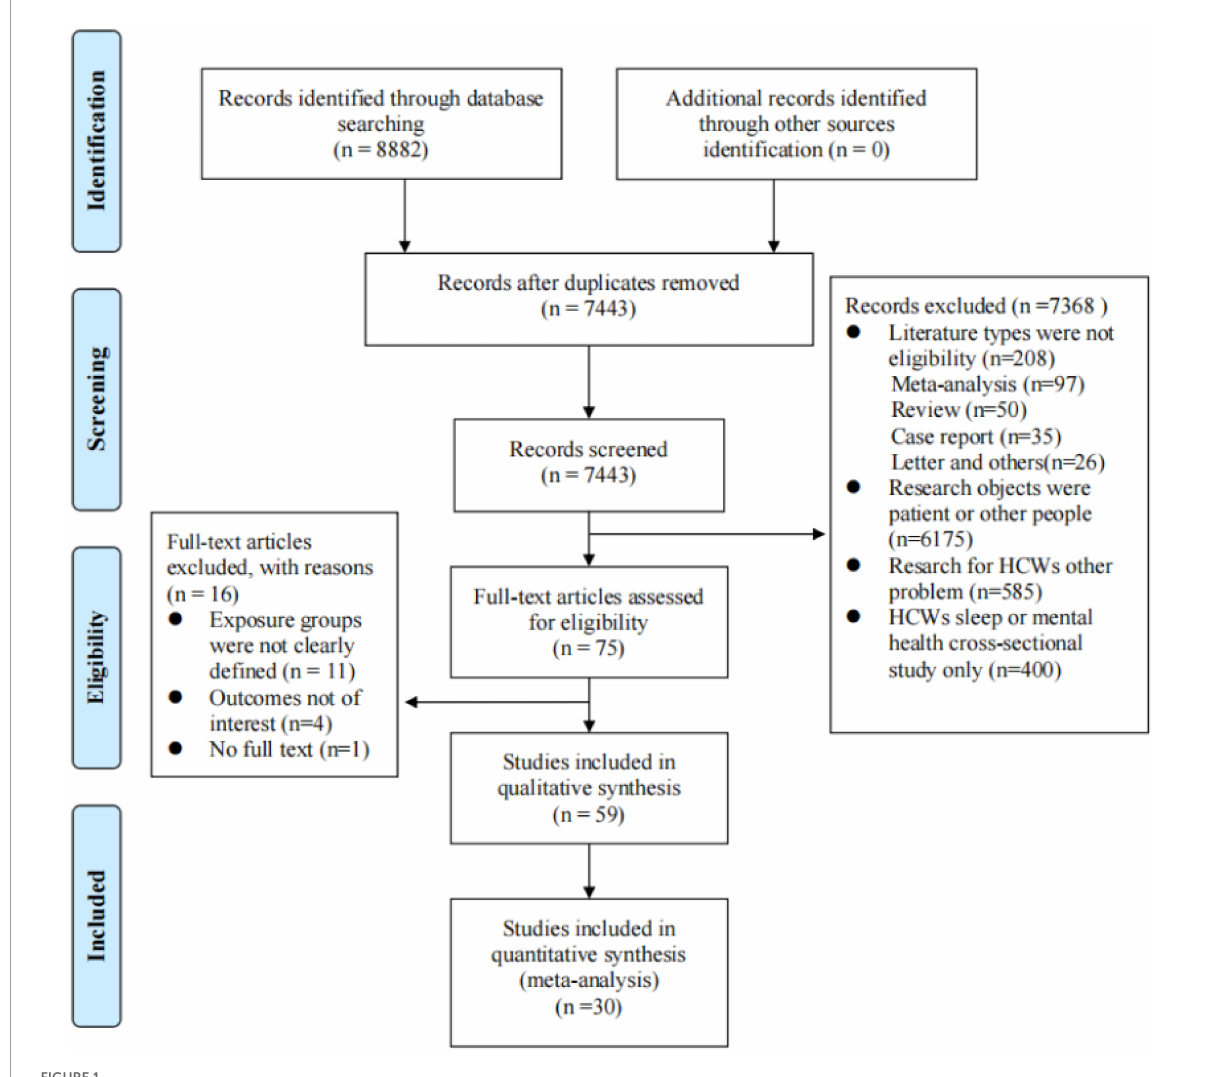
FIGURE1 PRISMA flow chart illustrating the selection process of